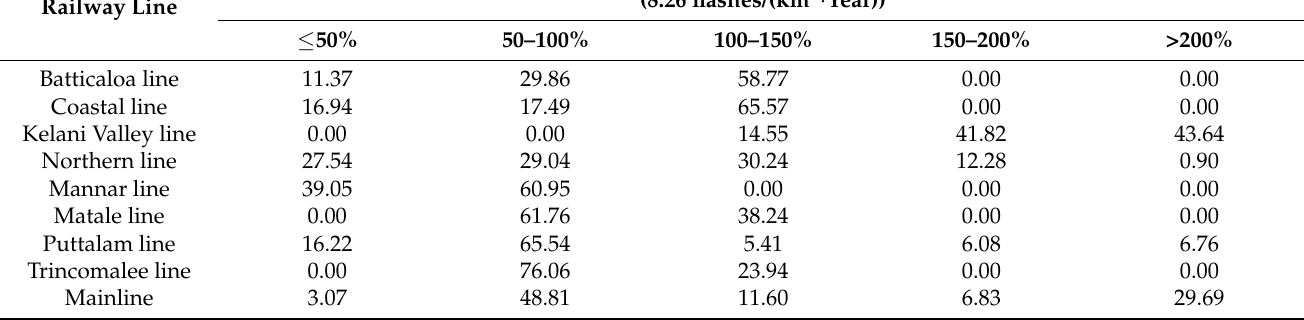
Table 3. Percentage distribution of lightning flash density relative to the annual average flash density of Sri Lanka over the railway